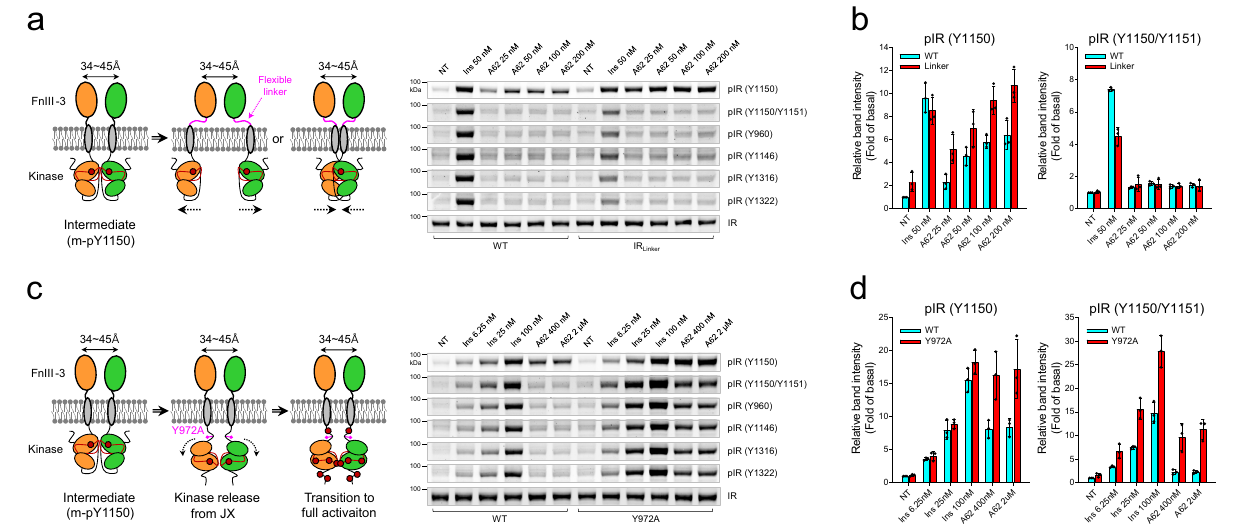
Fig.5|TheJMdomainplaysakeyroleinpreventingfullactivation.a Insulin-or A62-induced IR phosphorylation in CHO-K1 cells expressing WT IR or mutant IR witha fl exiblelinker(IR Linker ). b Quanti fi cationofwesternblotdataform-pY1150or pY1150/pY1151 shown in Fig. 5a. c Insulin- or A62-induced IR phosphorylation in CHO-K1 cells expressing WT IR or its Y972A mutant. d Quanti fi cation of western